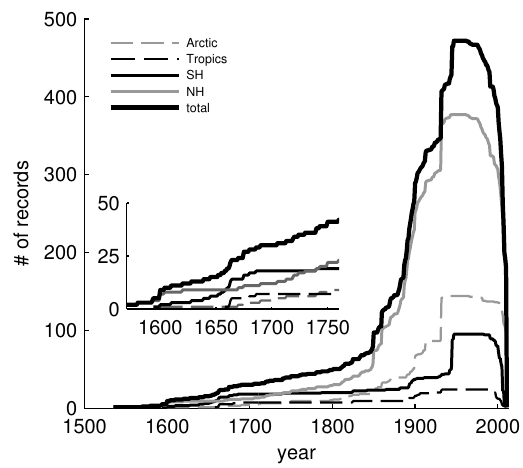
Fig. 4. Total number of glacier length records in time (thick black); number of records on the Southern Hemisphere (black) and North- ern Hemisphere (grey). The number of records in the Tropics (30 ◦ S – 30 ◦ N) and the Arctic ( ≥ 60 ◦ N) are given in dashed black and grey, respectively. The inset enlarges the period 1570–1760.